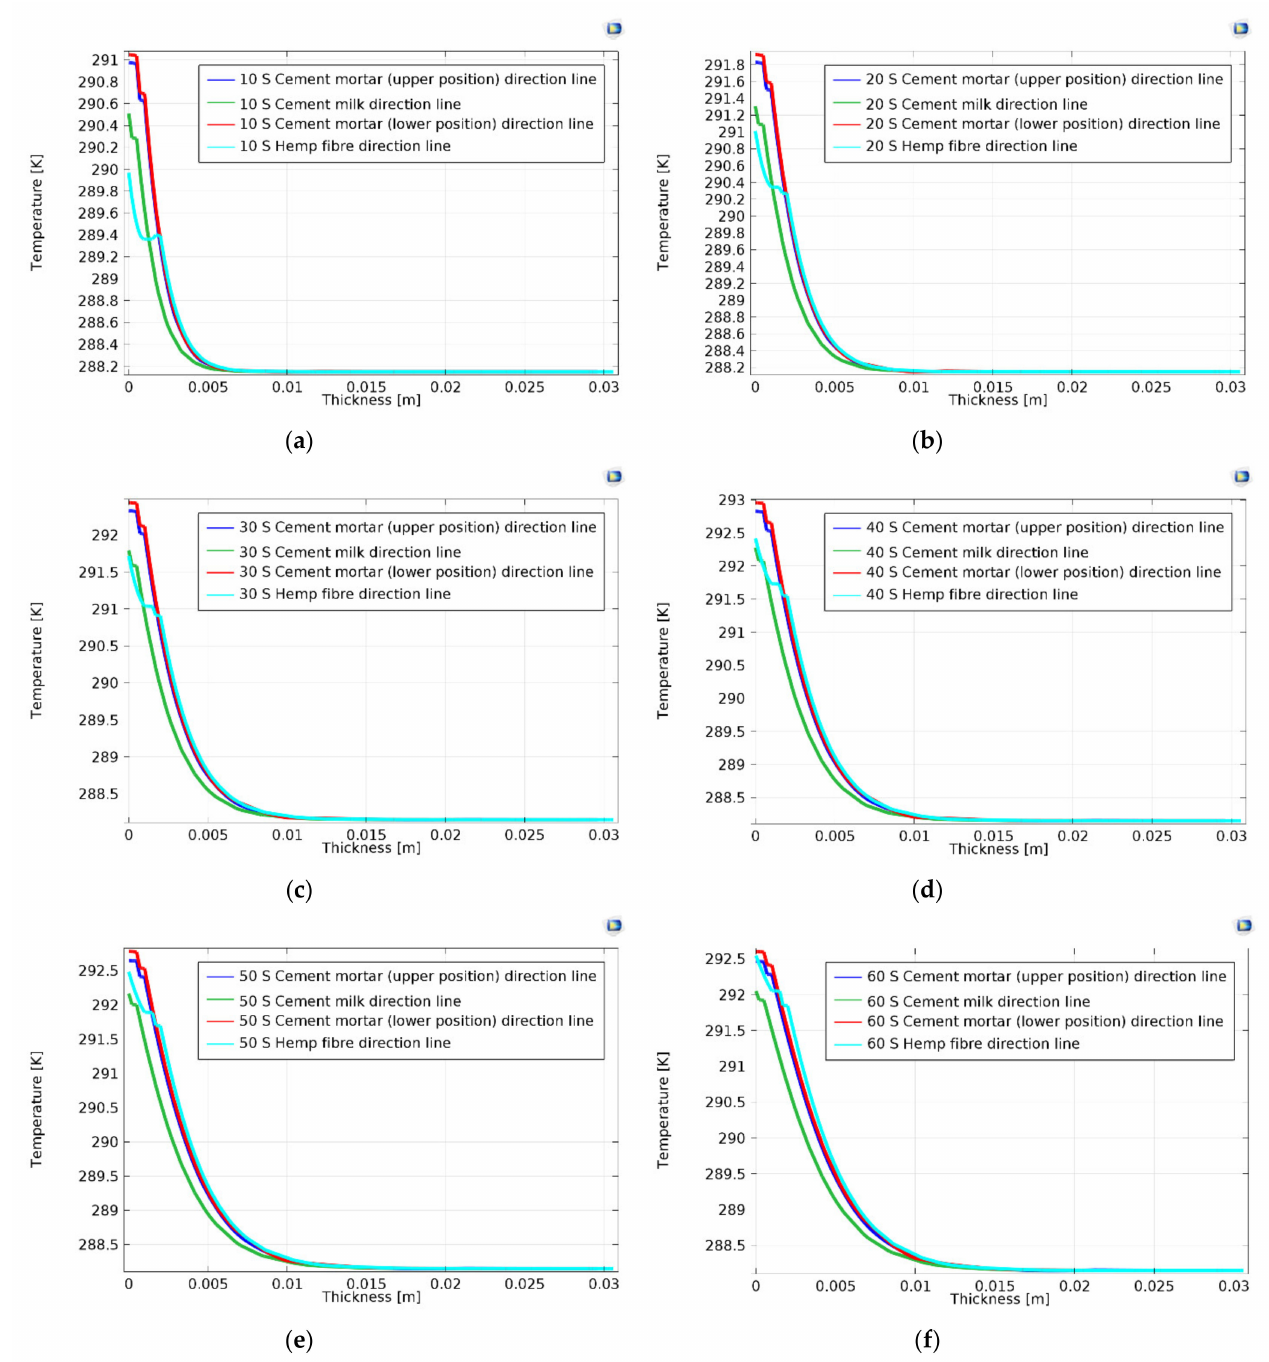
Figure 8. In-depth temperature profiles in the heating phase: ( a ) 10 s of heating, ( b ) 20 s, ( c ) 30 s, ( d ) 40 s, ( e ) 50 s, ( f ) 60